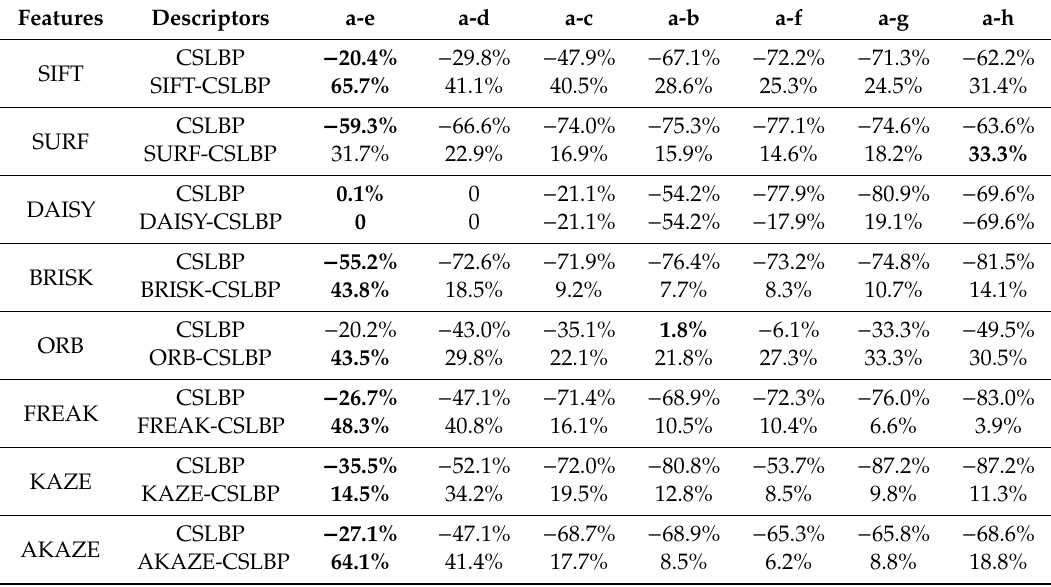
Table 4. The improved values of precision for the CSLBP and the combined descriptors compared to the original descriptors of Bikes